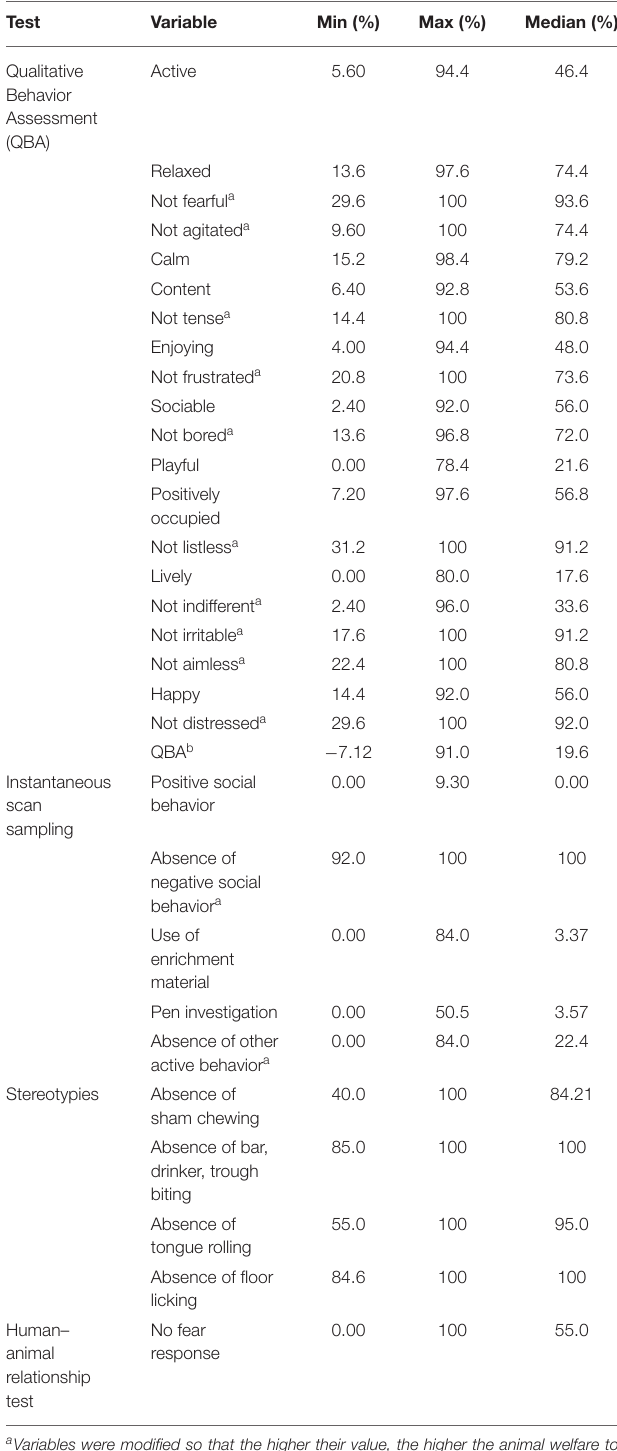
TABLE 2 | Minimum, maximum and median values (%) of the variables included in the PCA on sows’